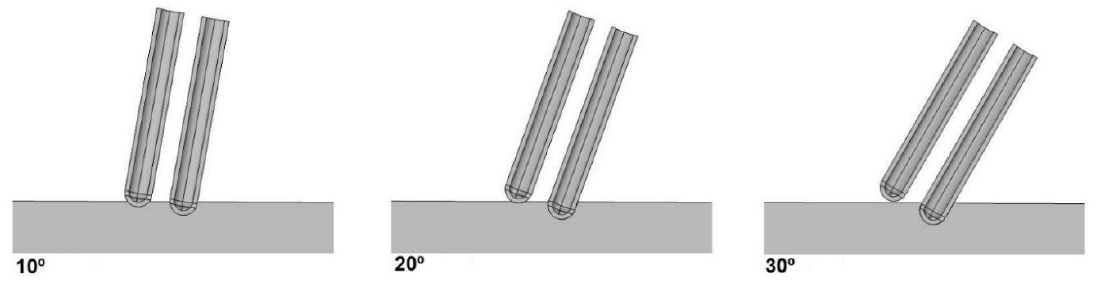
Figure 4. Three different angles of penetration considered for the geometry of the models used in the third set of simulations with rotation angles of 10°, 20°, and 30° with respect to the initial geometry.